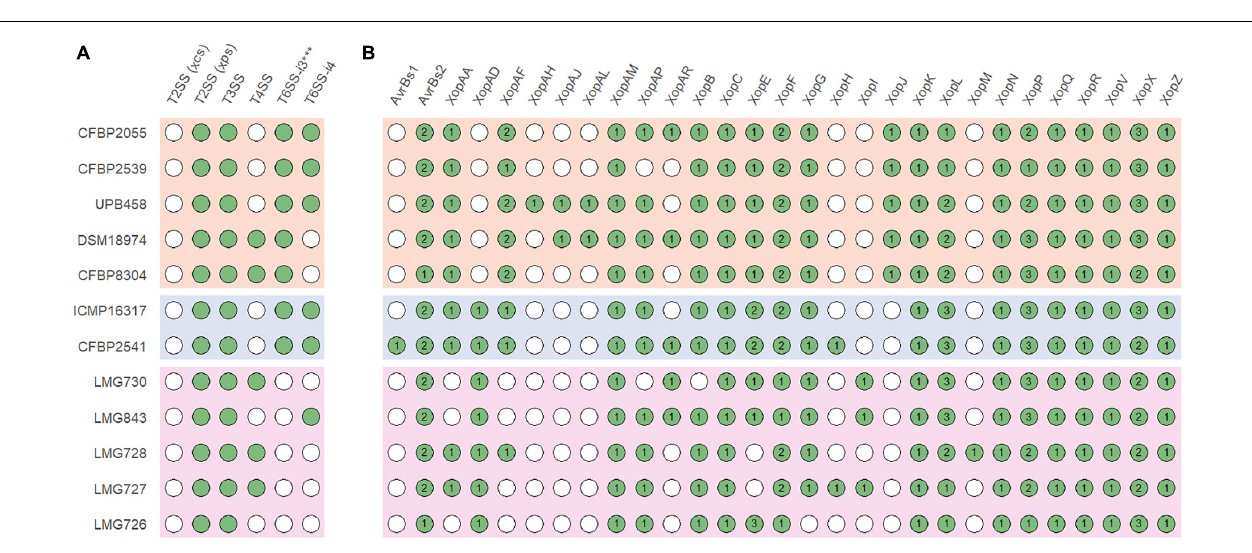
FIGURE 4 | (A) Presence of the xps and xcs type II secretion systems (T2SS), type III secretion system (T3SS), type IV secretion system (T4SS), subtype 3*** type VI secretion system (T6SS-i3***), and subtype 4 type VI secretion system (T6SS-i4) gene clusters in X. translucens pathotype strains. (B) Presence of putative type III effectors. Green circles indicate presence, and white circles indicate absence. Numbers denote the number of putative effectors of each class. Orange: clade Xt-I, blue: clade Xt-II, pink: clade Xt-III.